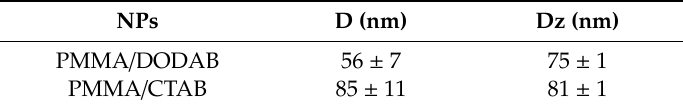
Table 1. Dry mean diameter (D) and mean hydrodynamic diameter (Dz) for PMMA / QAC NPs. D was from scanning electron microscopy (SEM) and Dz was determined by dynamic light-scattering (DLS). The nanoparticles (NPs) were obtained from 0.4 M methyl methacrylate (MMA), 2 mM dioctadecyl dimethyl ammonium bromide (DODAB) or cetyl trimethylammonium bromide (CTAB), and 0.36 mg · mL − 1 AIBN in 10 mL of 1 mM NaCl. The mean D was obtained using ImageJ software from 100 particles. NPs D (nm) Dz (nm) PMMA / DODAB 56 ± 7 75 ± 1 PMMA / CTAB 85 ± 11 81 ±